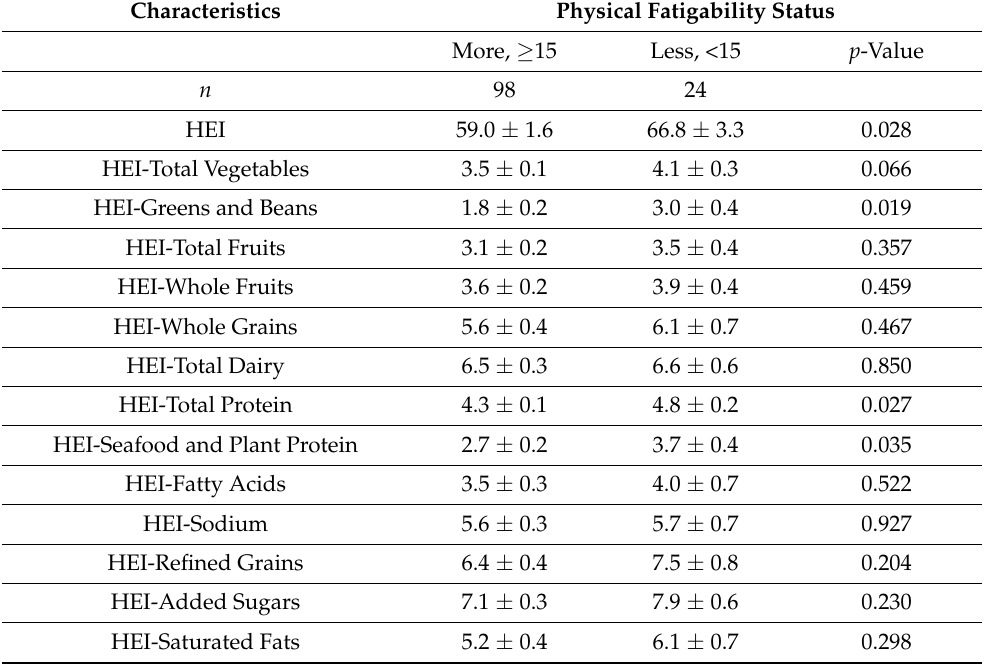
Table 2. Adjusted Healthy Eating Index (HEI) data in a subset of 122 oldest-old participants from the Geisinger Rural Aging Study according to perceived physical fatigability status: Pittsburgh Fatigability Scale